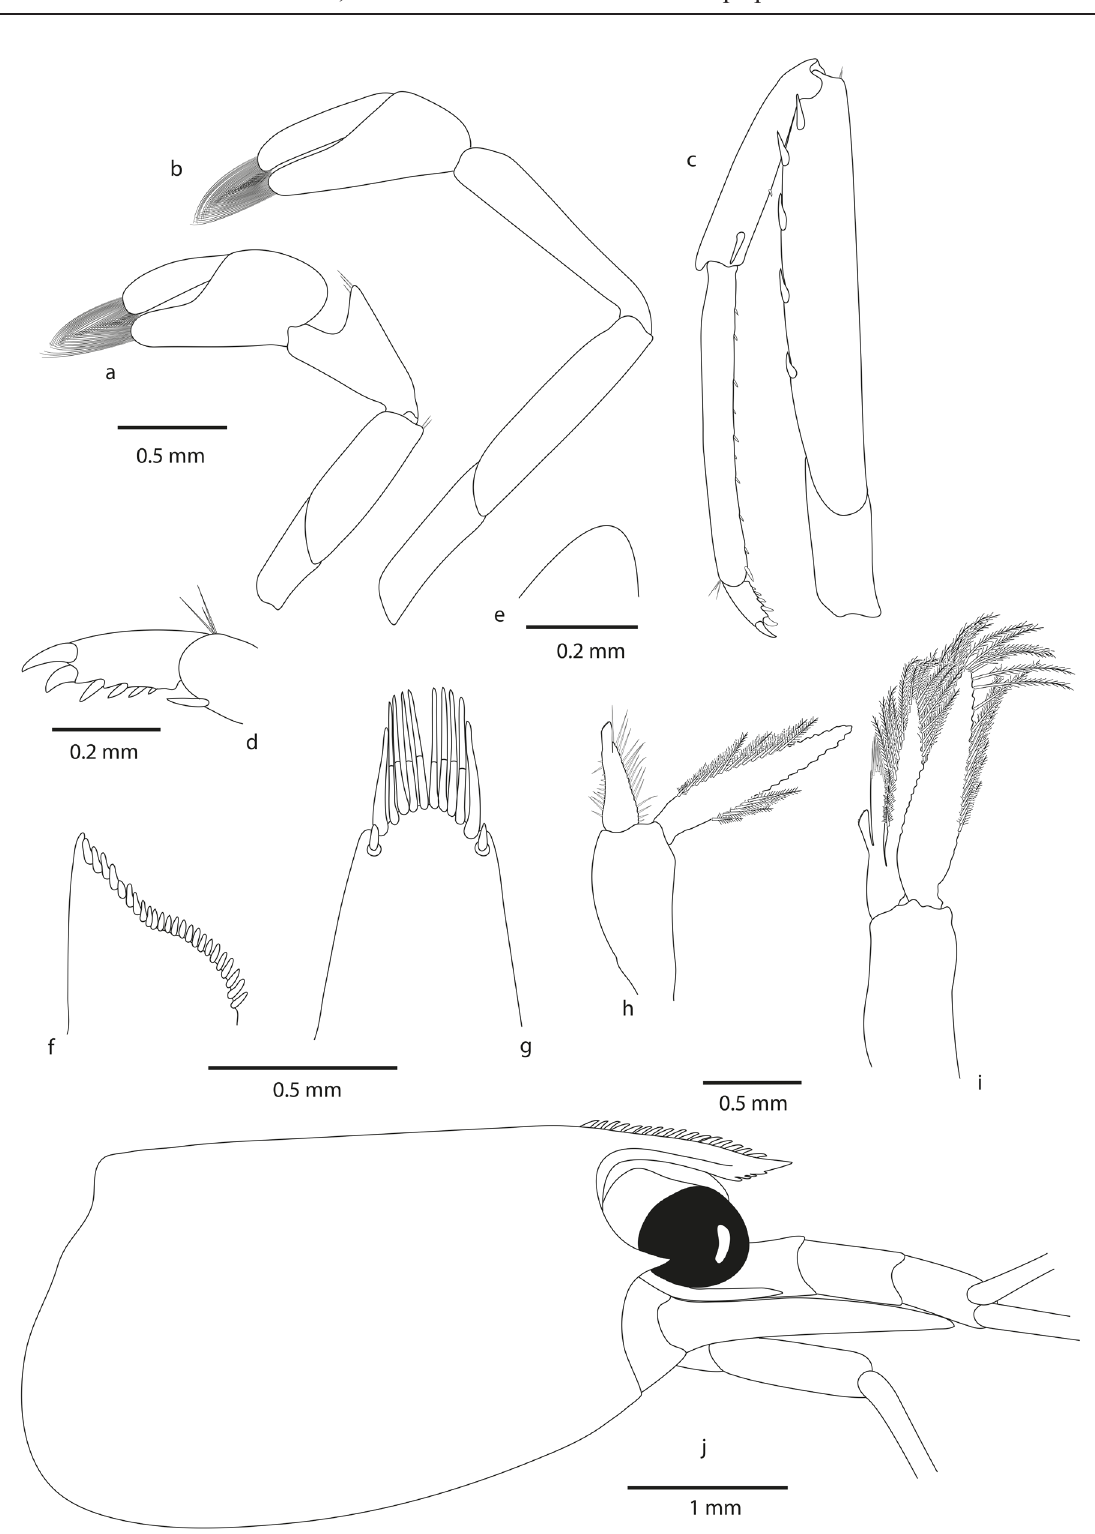
Fig. 20. Caridina sikipozo sp. nov. a . First pereiopod. b . Second pereiopod. c . Third pereiopod. d . Dactylus of third pereiopod. e . Pre-anal carina. f . Uropodal diaeresis. g . Telson. h . First male pleopod. i . Second male pleopod. j . Cephalothorax. MNHN-IU-2018-2914 (a–e, g, j) and MNHN-IU-2018-2915 (f,